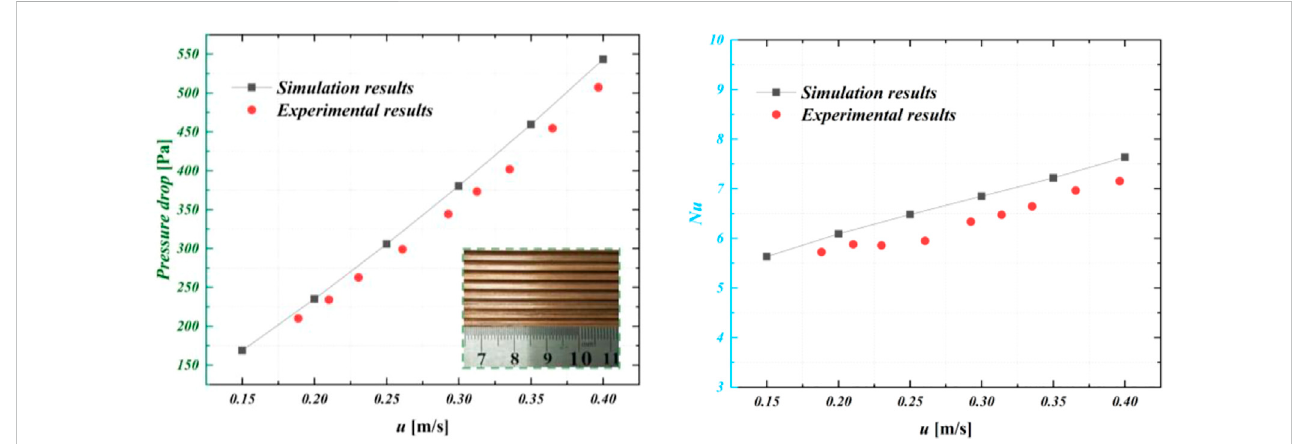
FIGURE 4 Comparison of experimental results (Chen et al., 2022b) and simulation results of △ P (pressure drop) and